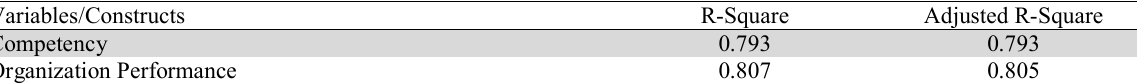
Assessment Level of R² Value of Coefficient of Determination Variables/Constructs